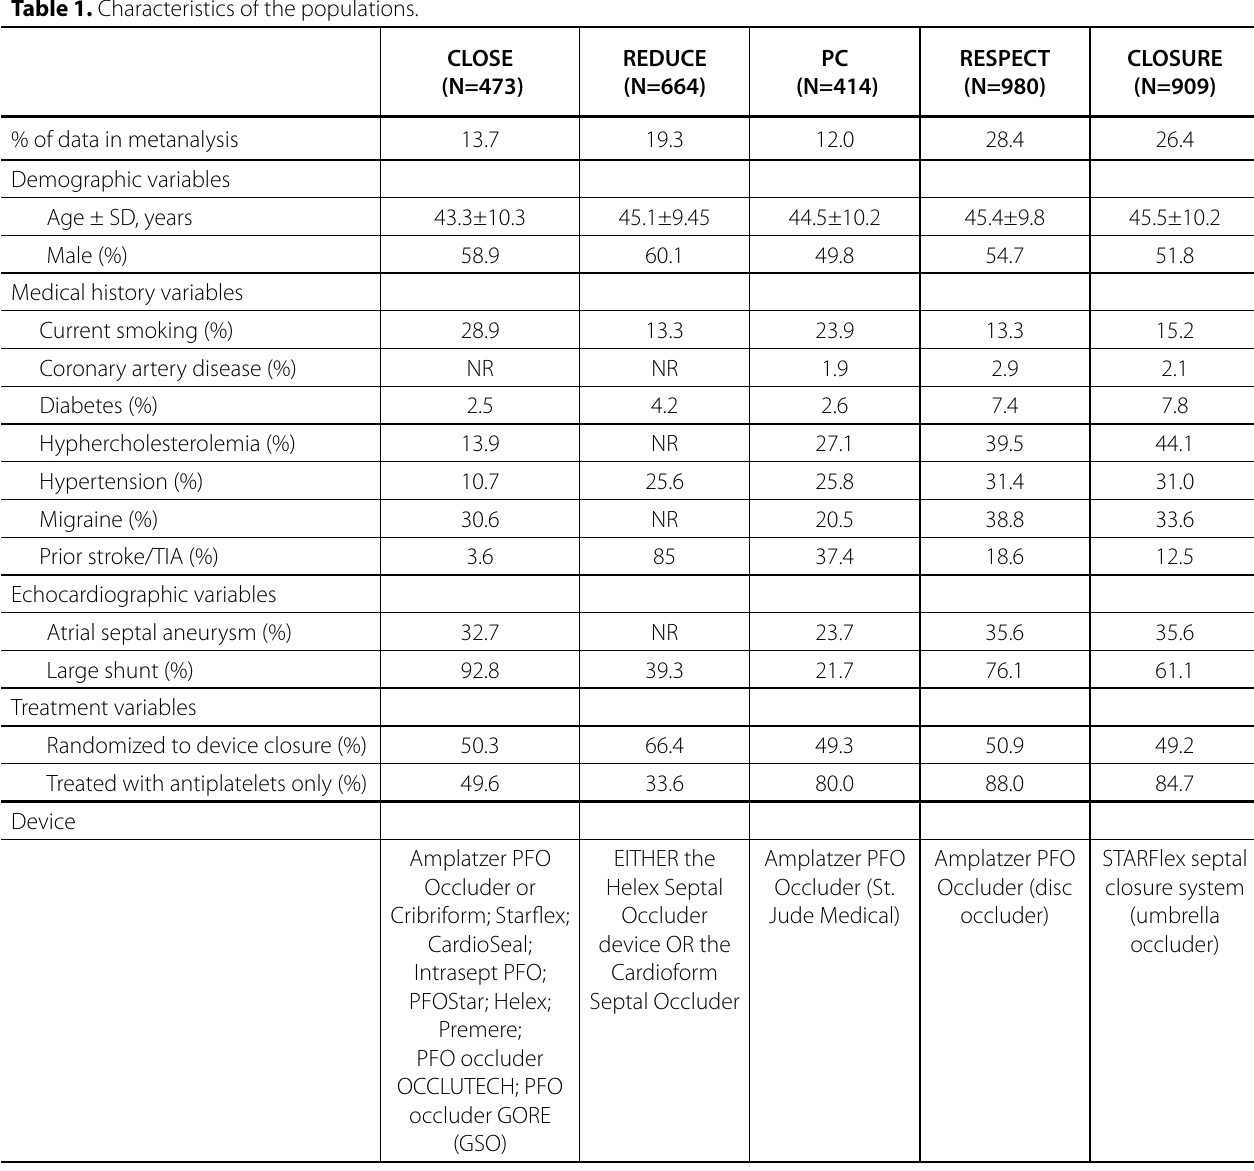
Table 1. Characteristics of the populations.